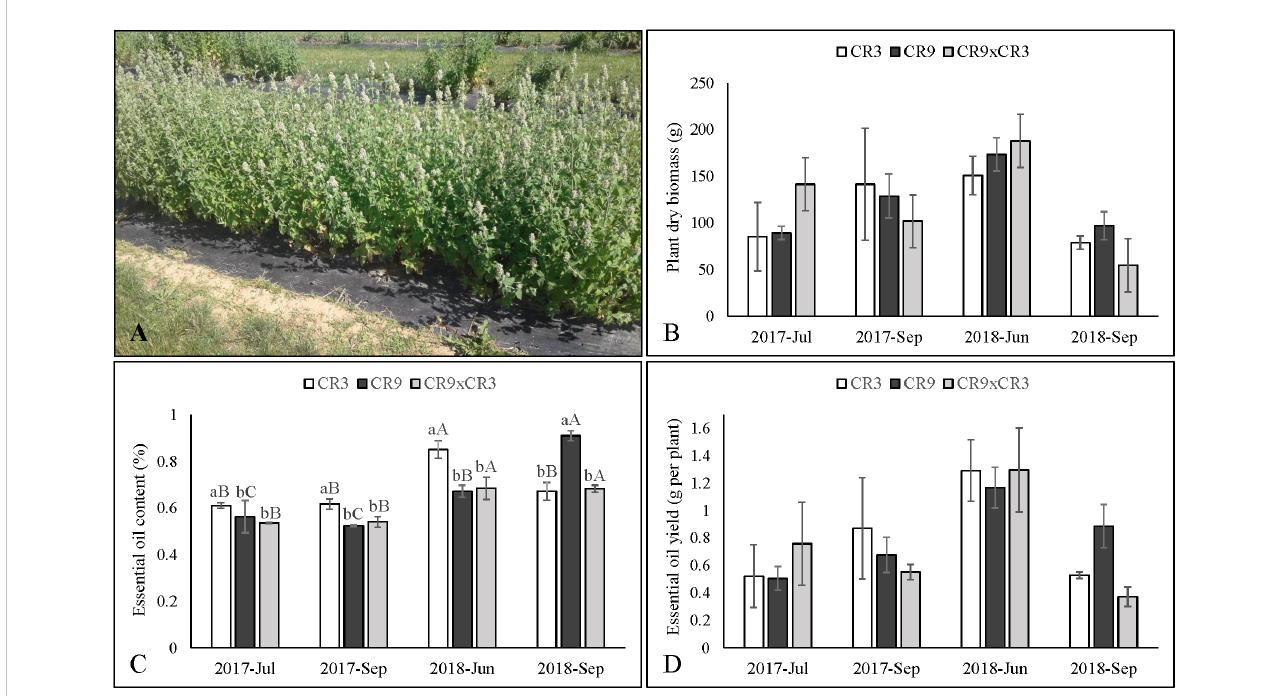
FIGURE 1 Aspect of catnip cultivar CR3 at harvest stage in September 2018 (A) , productivity of dry aboveground biomass (B) , essential oil content (C) and essential oil yield per plant (D) of catnip genotypes at different harvest times. Pittstown, NJ, United States. Vertical error bars indicate standard deviation. Uppercase letters indicate statistical comparisons of the same genotype across harvests and lowercase letters indicate comparisons among the three genotypes inside the same harvest. Averages with different letters are statistically different by the Scott-Knott test ( p ≤ 0.01). Plant Dry Biomass and essential oil yields do not contain letters because the interaction effects between genotypes and harvest times were not signi fi